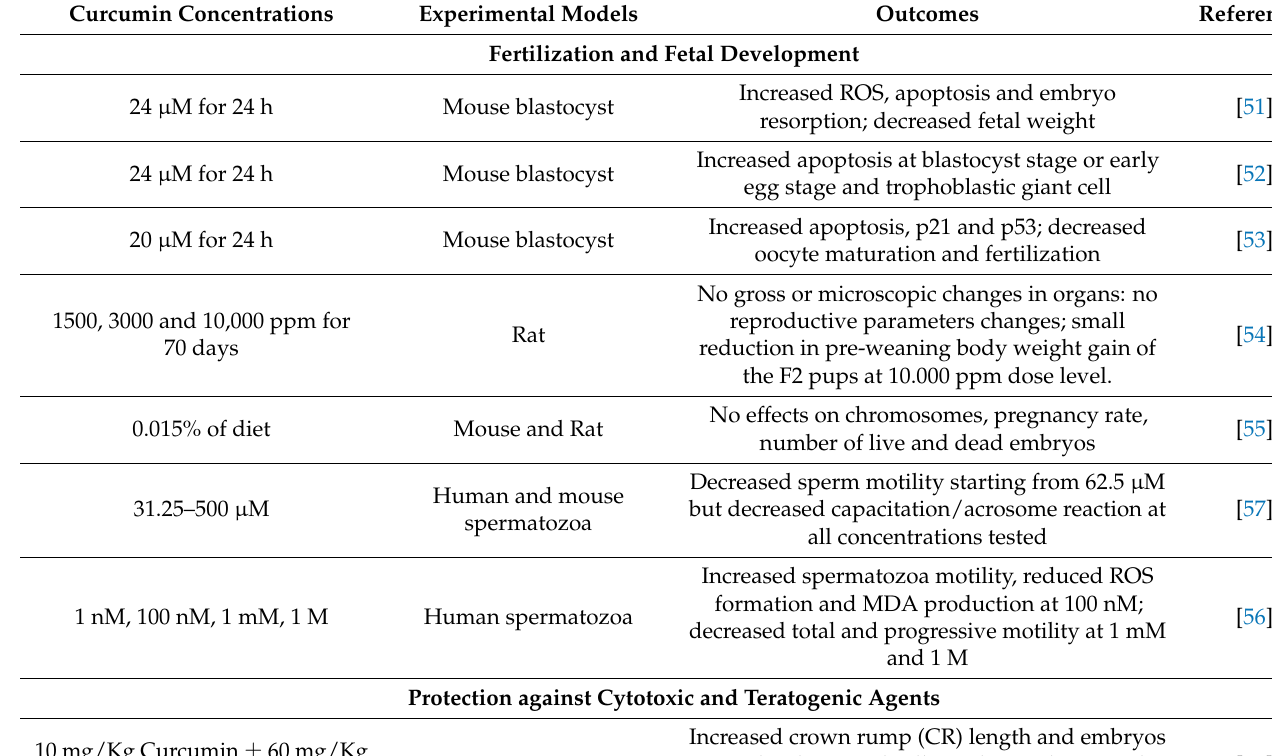
Table 1. In vitro and in vivo actions of